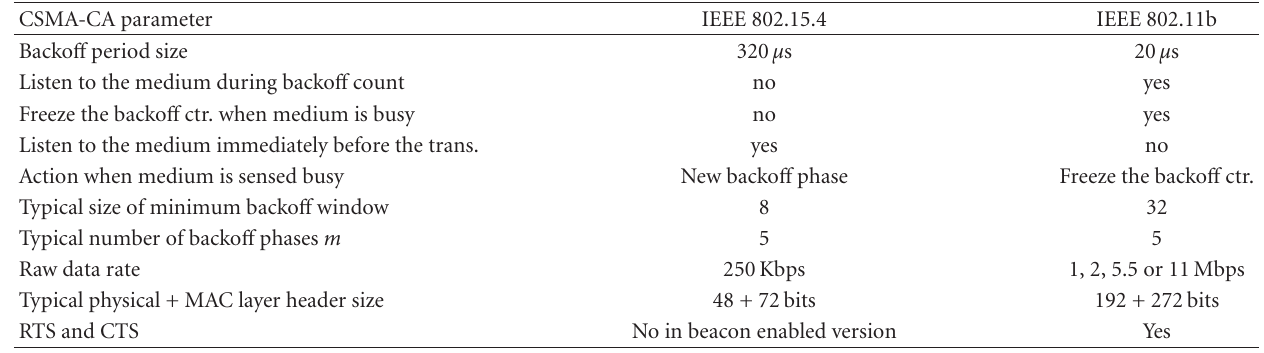
Table 1: Comparison of MAC parameters between beacon-enabled IEEE 802.15.4 and IEEE